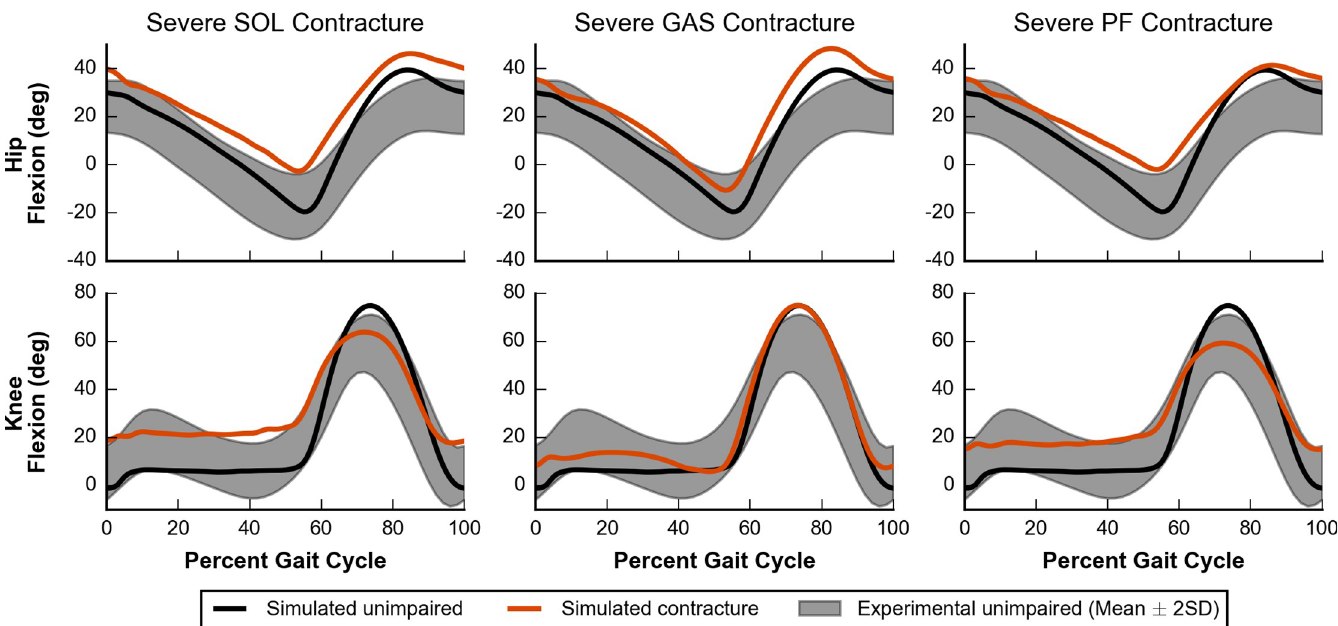
Fig 11. Hip and knee kinematics for severe contracture. Simulated hip and knee kinematics for unimpaired walking (black lines) and walking with severe contracture (orange lines) are compared to experimental data collected from unimpaired individuals (gray area) [58]. Hip flexion (top) and knee flexion (bottom) are plotted for cases of SOL (left), GAS (middle), and PF (right)